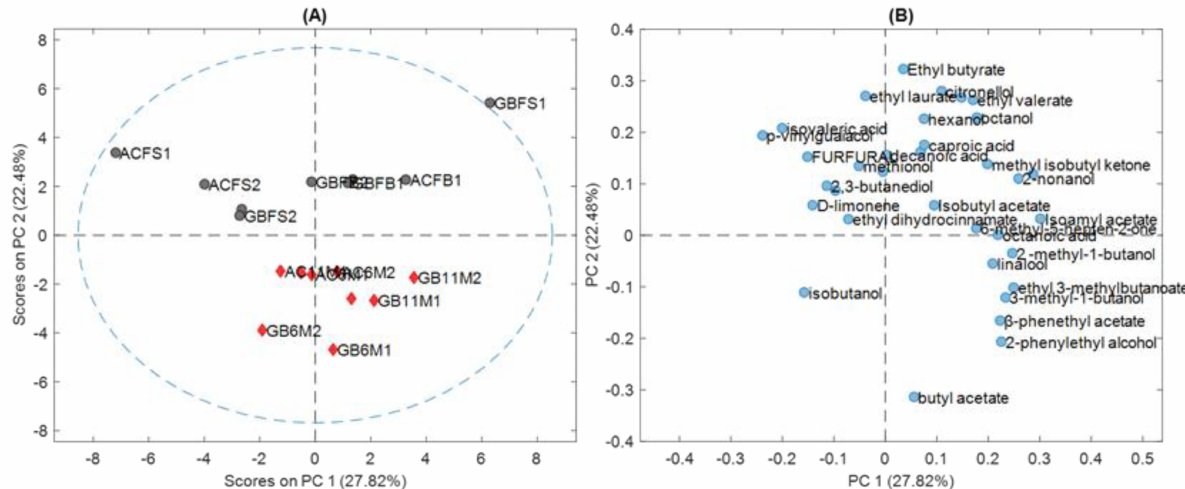
Figure 1. ( A ) Score plot of PCA analysis; ( B ) Loading plot of PCA analysis.